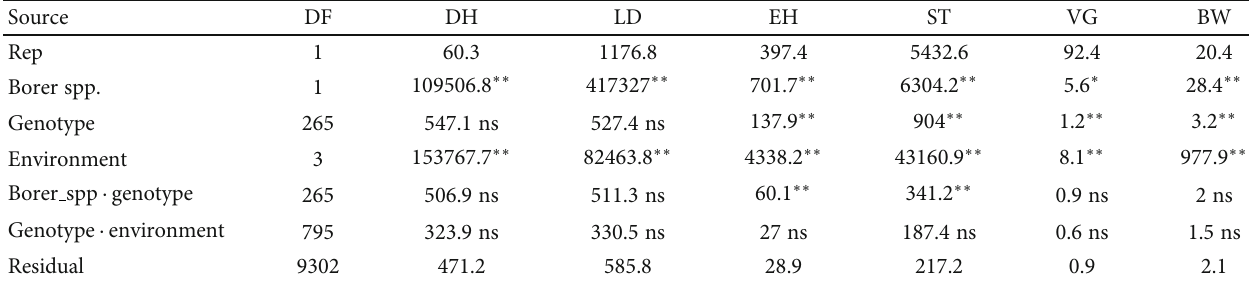
Table 1: Combined analyses of variance across environments.